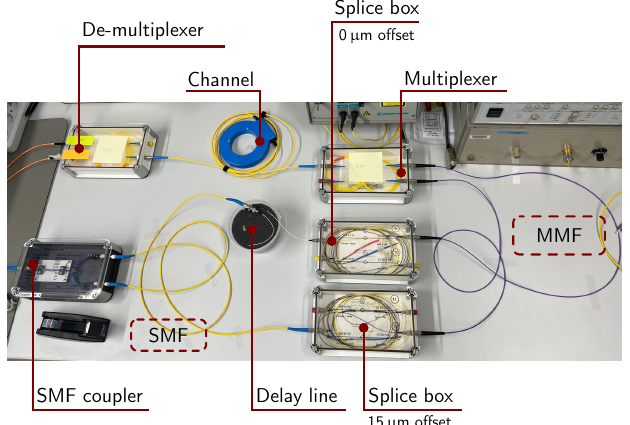
Figure 7. Experimental measurement setup with the PFS configuration using a 167.27 m delay line Figure 6. Experimental measurement setup with the PFS configuration using a 167.27m delay line and an MMF channel. and an MMF